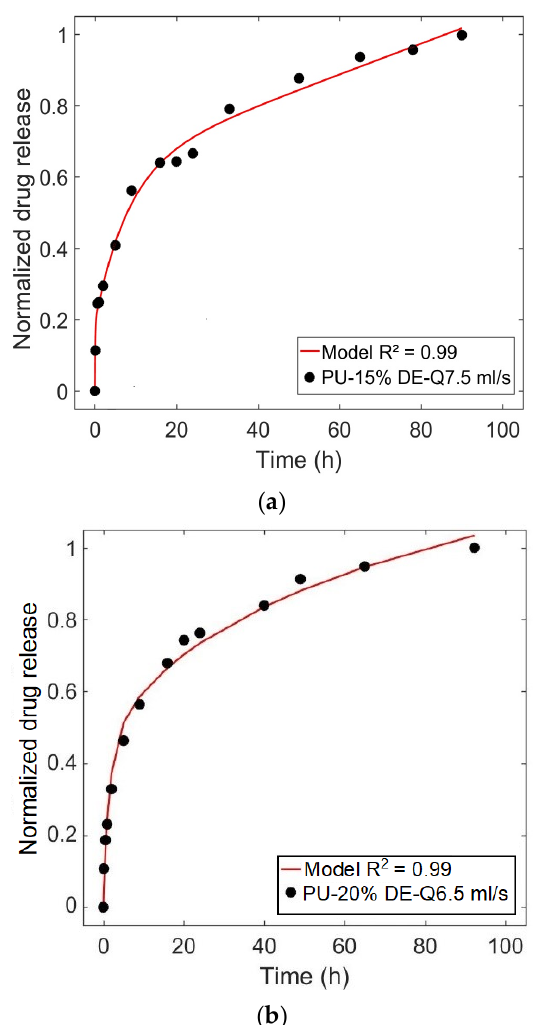
Figure 13. Comparison of the predicted release profile obtained by the model and the experimental data for the case ( a ) PU-15%DE-Q7.5 mL/s, ( b ) PU-20%DE-Q6.5 mL/s.